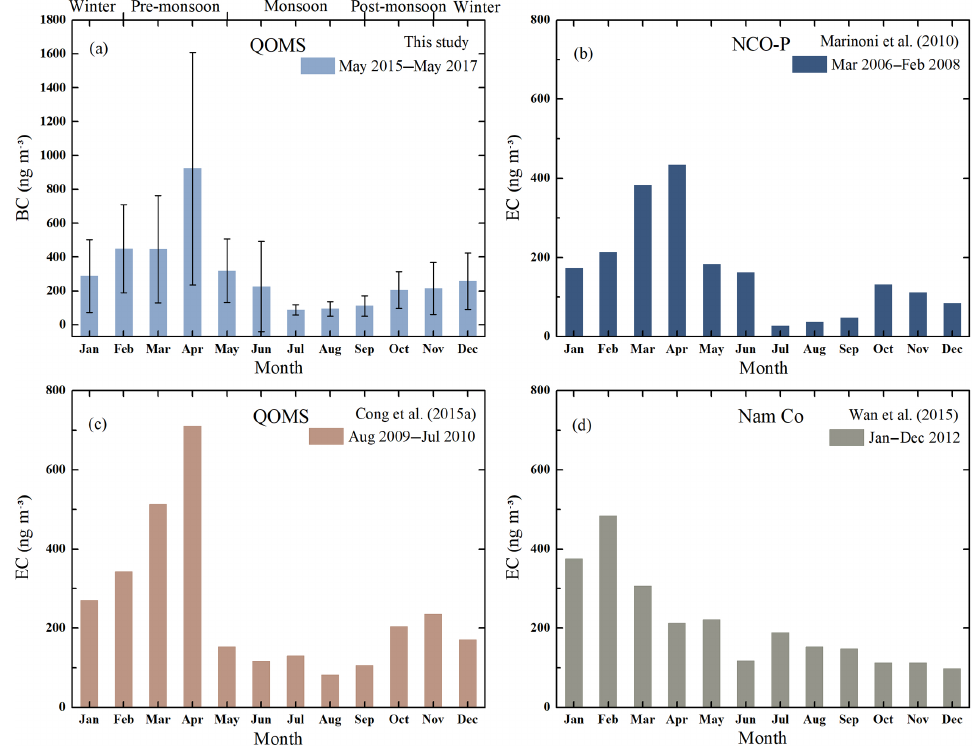
Figure 2. (a) monthly mean BC concentrations at QOMS from May 2015 to May 2017 in this study; (b) monthly mean EC at NCO-P from March 2006 to February 2008 from Marinoni et al. (2010); (c) monthly mean EC at QOMS from August 2009 to July 2010 from Cong et al. (2015a); (d) monthly mean EC at Nam Co station from January to December during 2012 from Wan et al.